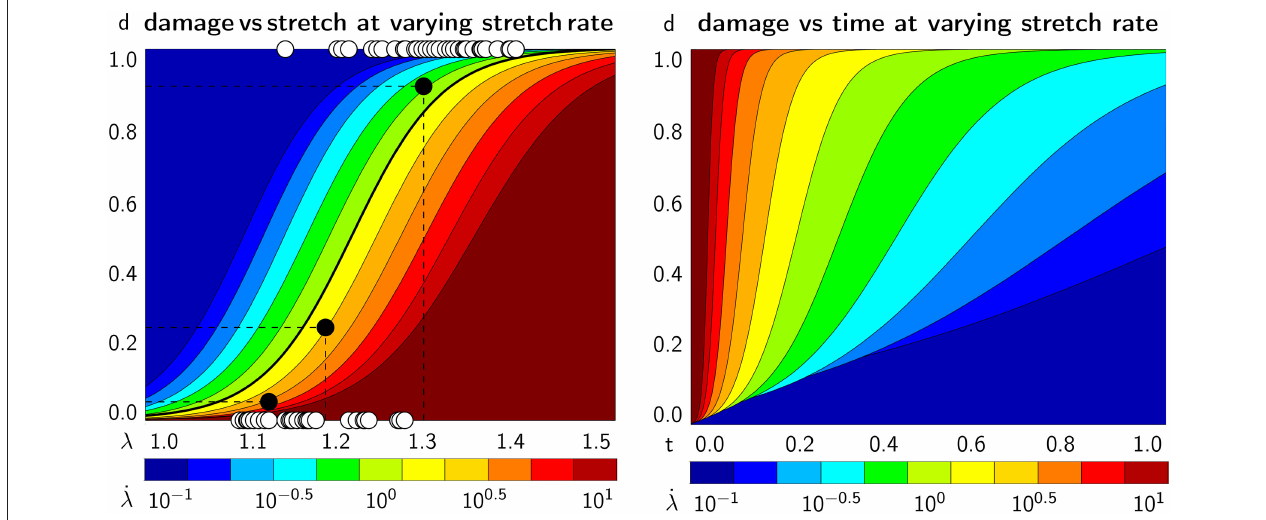
FIGURE 9 | Continuum axonal damage. Axonal damage vs. axonal stretch (Left) and time (Right) at varying stretch rates and constant bond strength. White circles represent experimentally characterized damaged, d = 1, and undamaged, d = 0, nervous tissue samples at different strain levels ( Bain and Meaney, 2000). Black circles define the conservative damage threshold at 14% strain, the liberal damage threshold at 34% strain, and the optimal damage threshold at 21% strain (Bain and Meaney, 2000 ). The graphs demonstrate an emergent feature of our transient crosslink model: For increasing stretch rates, damage develops at a larger stretch (Left) but earlier in time (Right) .